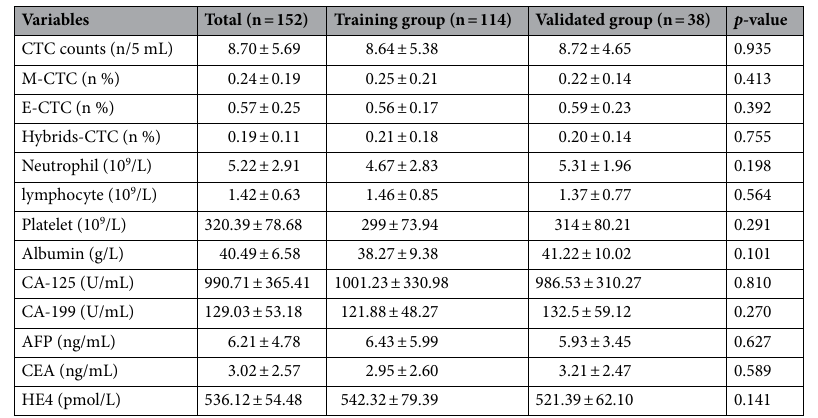
Table 2. Clinical features of the 152 epithelial ovarian cancer (EOC) patients involved grouped by training set and validation set. CTC circulating tumor cell, M-CTC mesenchymal CTCs/ total CTCs percentage, E-CTC epithelial CTCs/ total CTCs percentage, Hybrids-CTC hybrids CTCs/ total CTCs percentage, CA-125 carbohydrate antigen-125, CA-199 carbohydrate antigen-199, CEA carcinoembryonic antigen, AFP alpha-